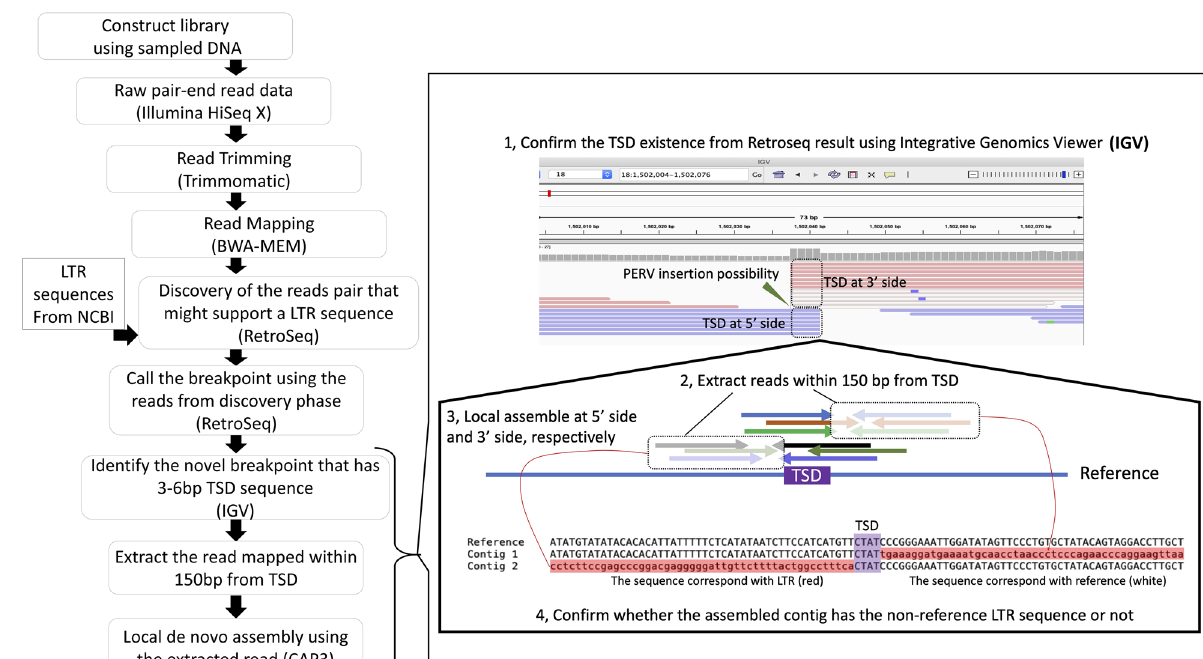
Figure 2. Pipeline for the detection of non-reference porcine endogenous retroviruses-long terminal repeats (PERV-LTRs) in whole-genome sequencing (WGS) read data. The presence of target site duplications (TSD) was confirmed at each locus detected by RetroSeq, extracted support reads from the TSD loci, performed local assembly, and analyzed the contigs for the presence of LTR-genome junctions from both sides. The upper